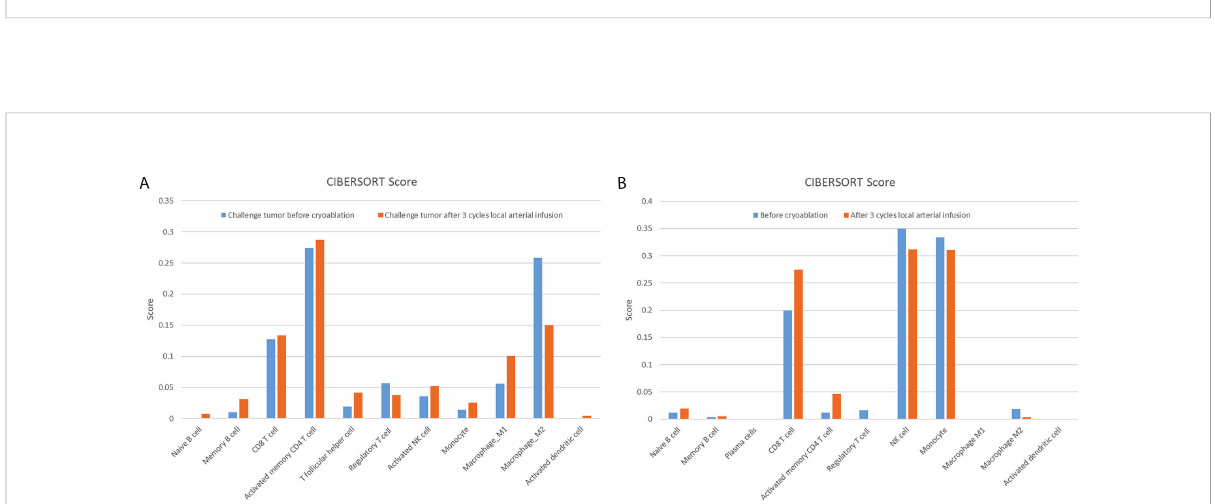
FIGURE 3 Challenged tumour (A) and matched peripheral blood (B) are associated with a variety of tumour-in fi ltrating immune cells. The related scores of eleven types of tumour-in fi ltrating immune cells, calculated using the CIBERSORT software, are shown in a bar